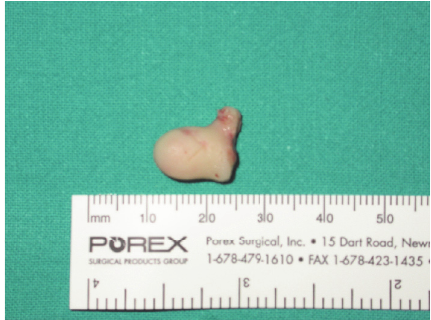
Figure 2: The excised mass; histological exam was consistent with a clear cell renal cell